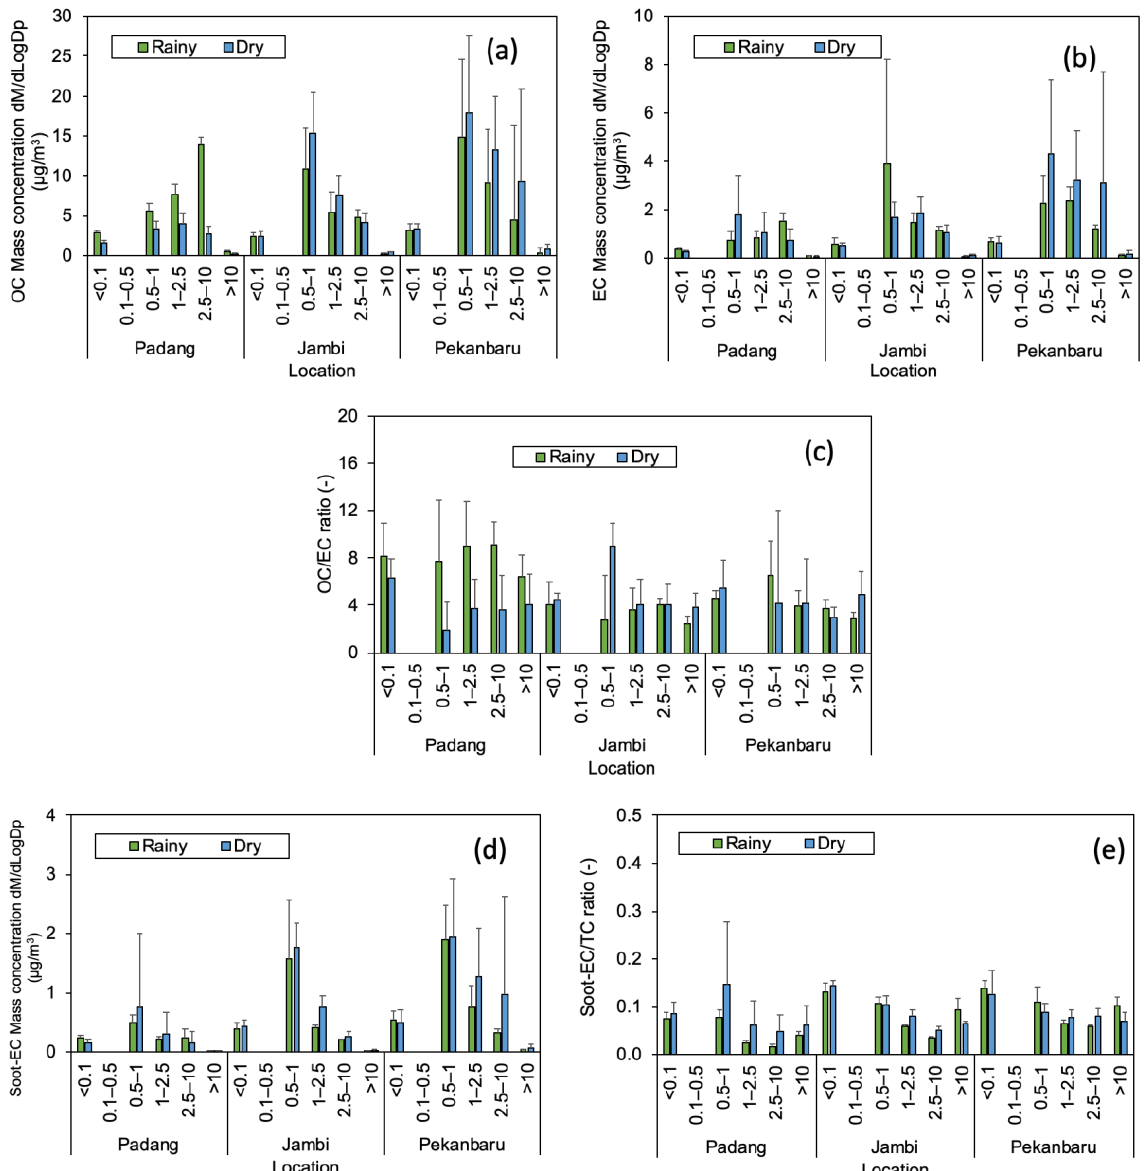
Figure 6. Carbonaceous components in three different cities in Sumatra island: ( a ) OC, ( b ) EC, ( c ) OC/EC, ( d ) soot-EC, and ( e ) soot-EC/TC.